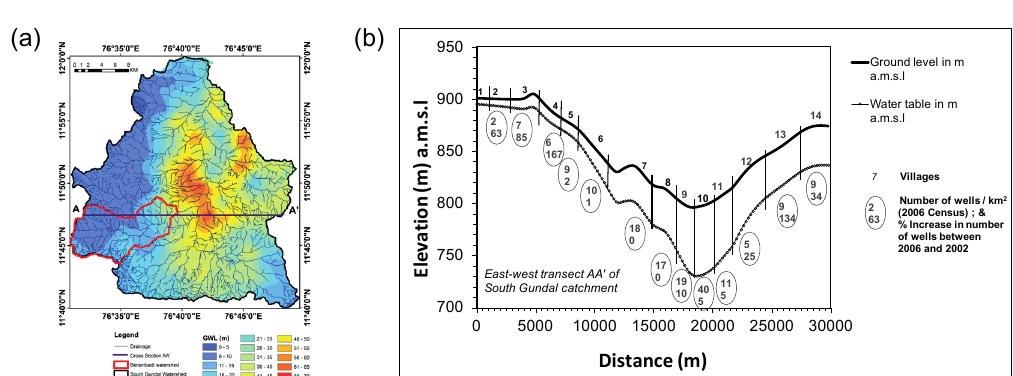
Fig. 1 Illustration of data acquisition in the South Gundal watershed: (a) stream drainage and depth to groundwater levels (obtained using about 600 disused bore wells); (b) topographic elevation (in m a.m.s.l.) and water table level along the transect